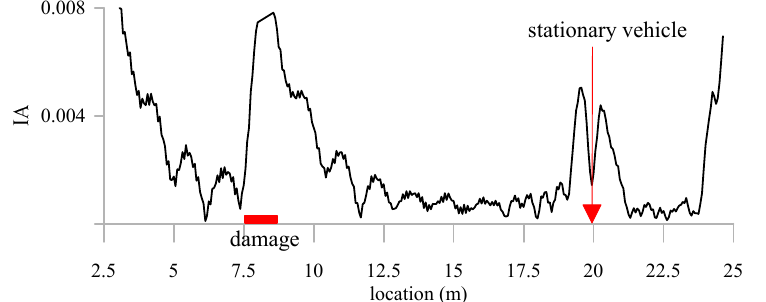
Figure 6. IA of the contact-point response of a stationary vehicle parked far from the location of the damage.